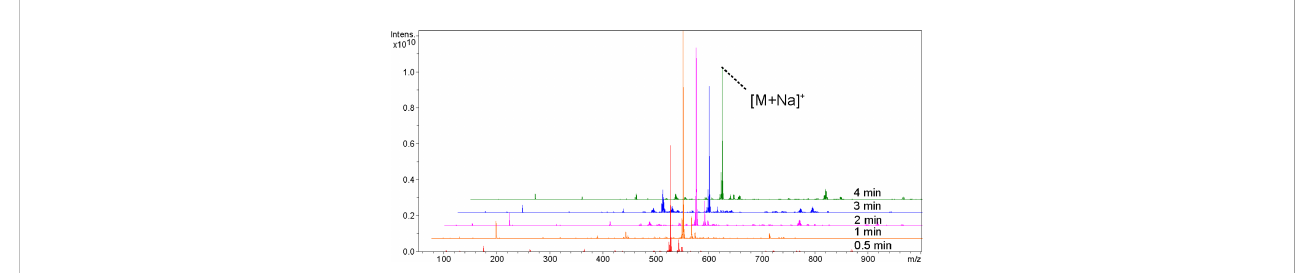
FIGURE 1 Comparison of ion signal intensities of Raf fi nose at 0.5, 1, 2, 3, and 4 min sputtering